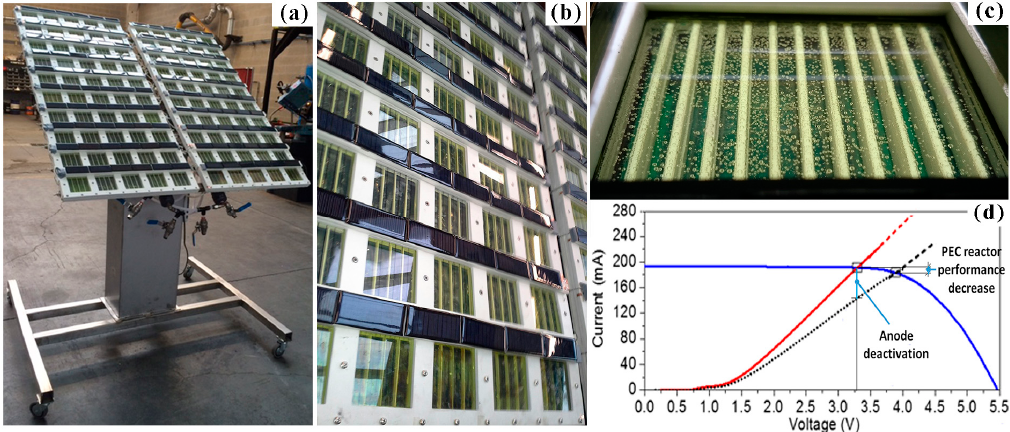
Figure 8. ( a ) Photograph and ( b ) close view of the 1.6 m 2 Artiphyction prototype made of 100 PEC cells (each of them with a 8 × 8 cm 2 BiVO 4 -based window); ( c ) photo of a single PEC cell of the prototype under operation; ( d ) I–V plots for a single PEC window of the Artiphyction prototype. Blue line: I–V power generation curve of the Si-PV cell for each window; red and black line/dotted line: initial and final PEC cell performance under 1 sun irradiation (AM 1.5 G); light-blue lines: possible performance degradation of a PEC cell prototype.